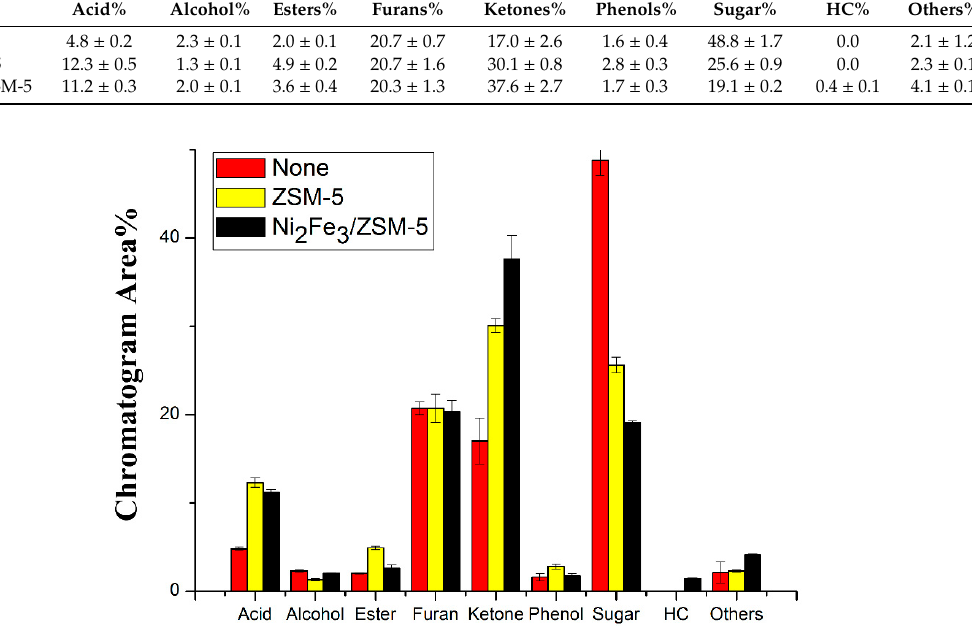
Figure 6. Chemical relative compositions of the organic phase of bio-oil without/with the ZSM-5 and Ni 2 Fe 3 / ZSM-catalysts (heterogeneous catalysis) and None: no